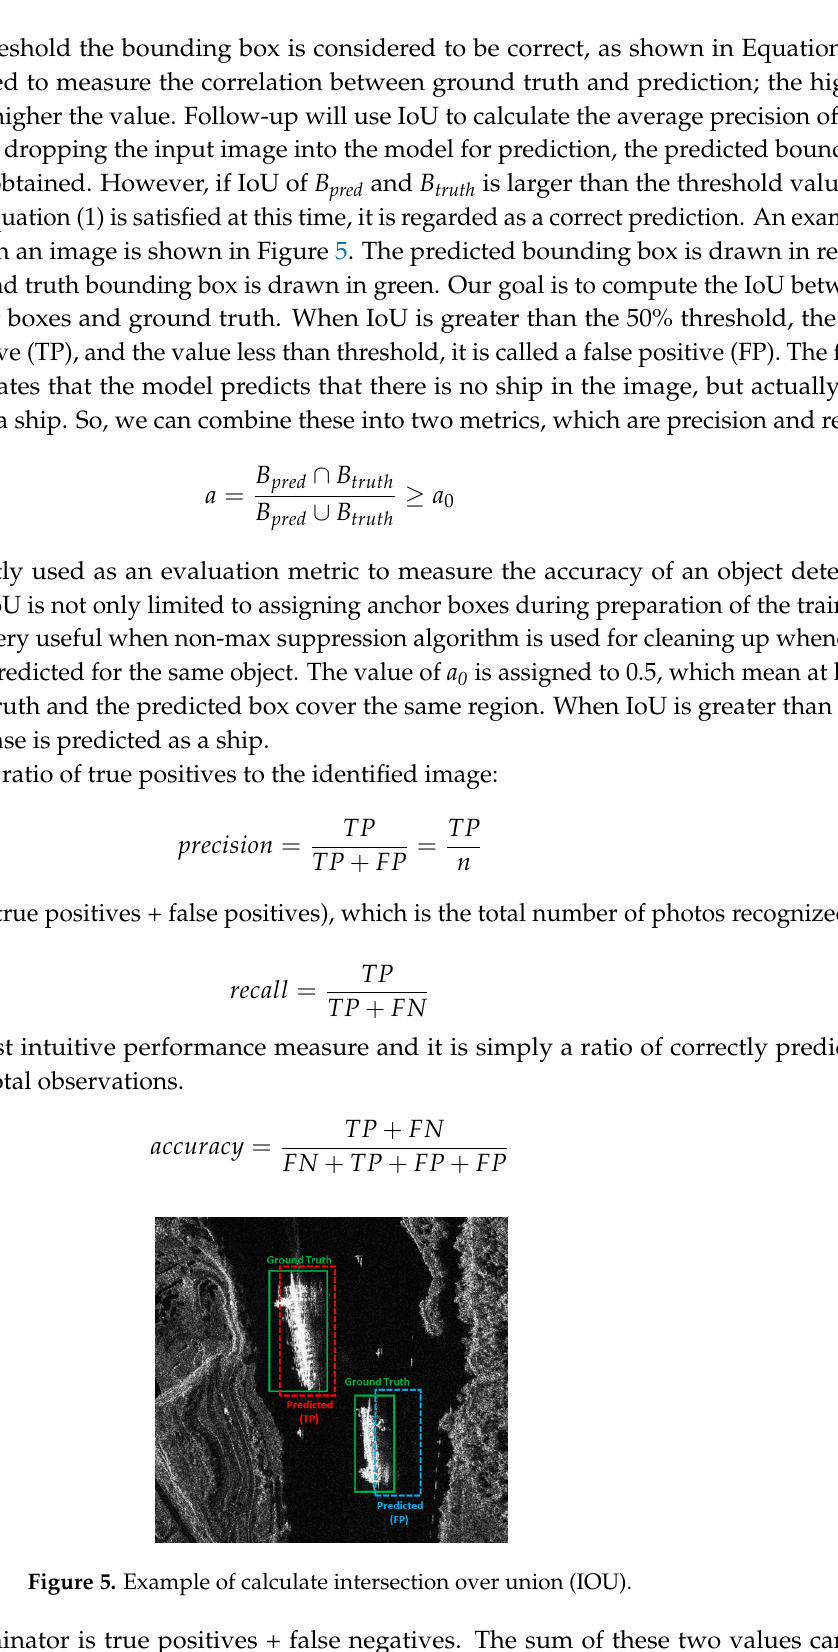
Figure 6. Examples of ship detection in different cases.